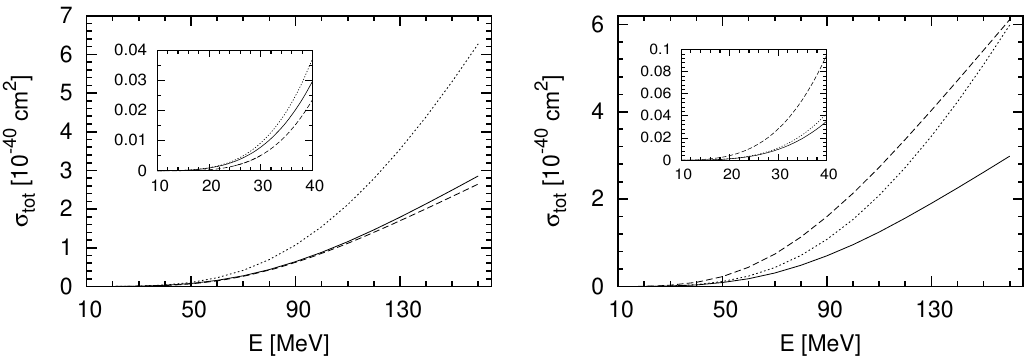
Figure 2: (left) Cross section for three inclusive (anti)neutrino reactions with 3 H: charged current electron antineutrino disintegration of 3 H (dashed line), neutral cur- rent electron antineutrino disintegration of 3 H (solid line), neutral current electron neutrino disintegration of 3 H (dotted line). (right) Same as left, but substituting 3 H with 3 He. These figures have been taken from Ref. [ 6 ]